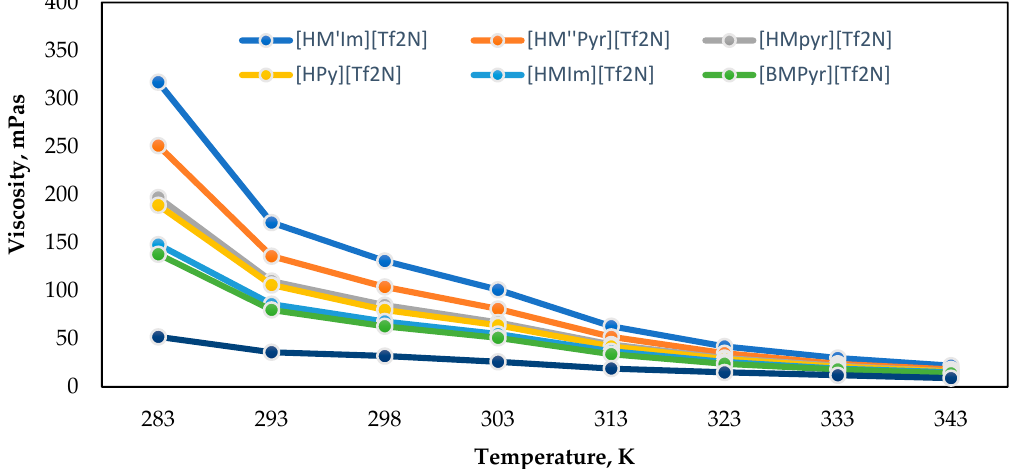
Figure 2. Figure showing the comparison of viscosity of air and water-stable ILs with cationic chain lengths at different temperatures: 283:343 K. Cations: [HM’Im] + ; [HM’Pyr] + ; [HM”pyr] + ; [Hpyr] + ; [HMIm] + ; [BMpyr] + ;[EMIm] + . Anion: [Tf 2 N] − . Plotted based on the data from